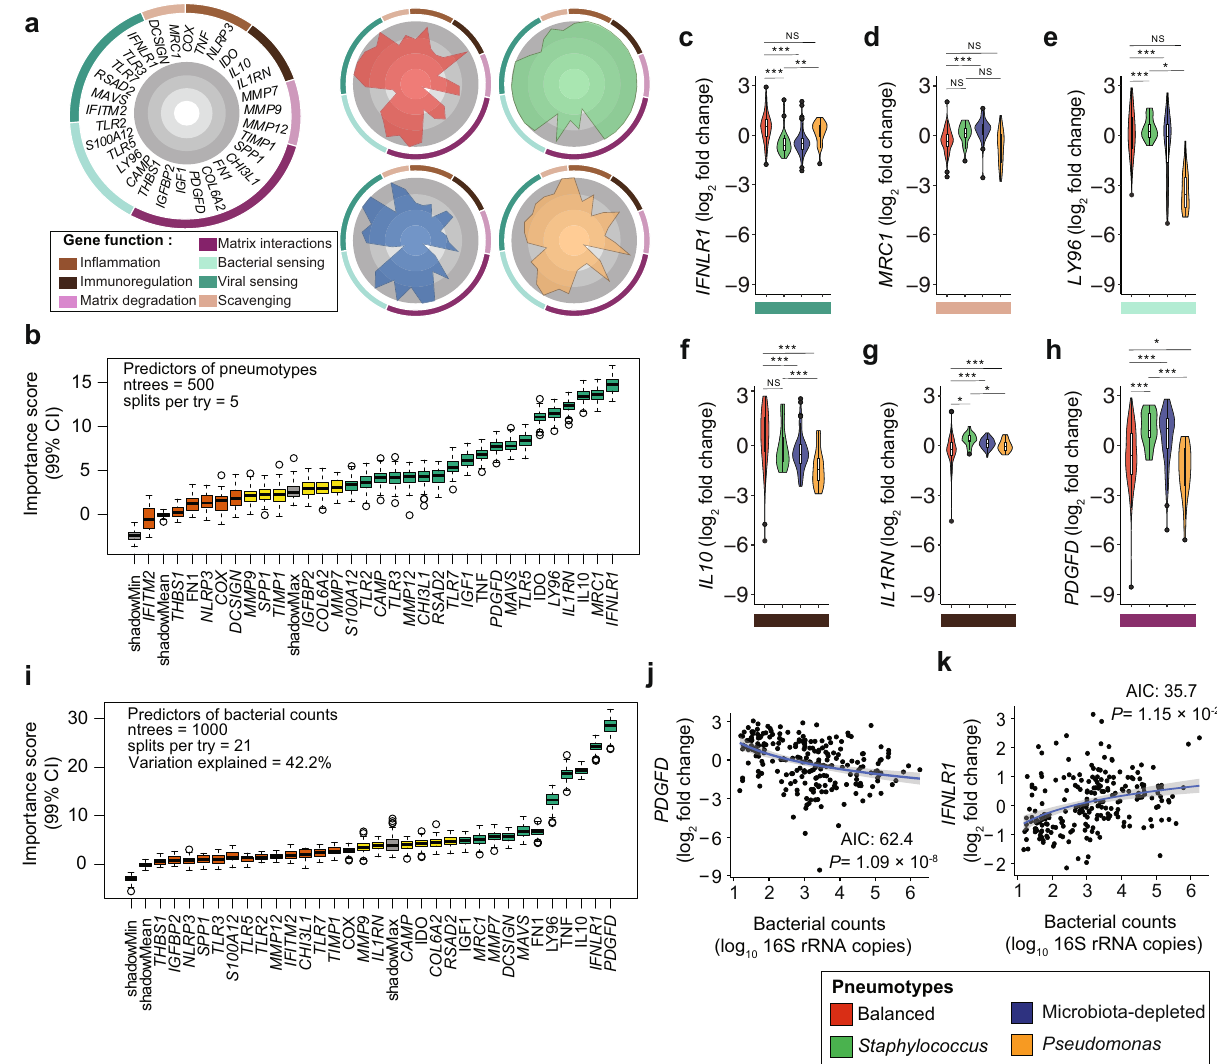
Fig. 4 Host gene expression in the lung differs according to pneumotype and bacterial load. a Radar plots show median-normalized expression of 31 host genes (radial axes) in the cell fraction of all BALF samples split by four pneumotypes. Circular distribution of genes is color-coded by seven functional categories and ticks (gray shading) show increase in expression from the inside to outside of the circle. b Importance scores (99% Con fi dence Interval) of host genes predictors of pneumotypes analyzed by Random Forest classi fi cation model and Boruta feature selection. Predictor genes are categorized into Con fi rmed (Green), Tentative (Yellow) and Rejected (Orange), ntrees = number of decision trees, splits per try = number of random predictors sub- sampled. c – h Violin plots showing distribution of expression (log 2 fold) of host genes with Importance scores >10 for pneumotype prediction ( n = 229): IFNLR1 (Kruskal test, χ 2 = 59.18, df = 3, two-sided, P = 8.8 × 10 − 13 ), MRC1 (ANOVA, F (3, 225) = 17.93, two-sided, P = 1.8 × 10 − 10 ), LY96 (Kruskal test, χ 2 = 33.87, df = 3, two-sided, P = 2.1 × 10 − 7 ), IL10 (Kruskal test, χ 2 = 58.82, df = 3, two-sided, P = 1.0 × 10 − 12 ), IL1RN (Kruskal test, χ 2 = 58.02, df = 3, two- sided, P = 1.5 × 10 − 12 ) and PDGFD (Kruskal test, χ 2 = 58.02, df = 3, two-sided, P = 8.7 × 10 − 10 ) across the pneumotypes. i Importance scores (99% Con fi dence Interval) of host genes in predicting bacterial counts analyzed by Random Forest regression model and Boruta feature selection. In addition to ntrees and splits per try = number of random predictors sub-sampled at each step and percent variance explained. j , k Scatter plots show correlation between expression(log 2 fold) of PDGFD (stepwise regression AIC = 62.4, ANOVA, t = − 5.9, P = 1.09 × 10 − 8 ) and IFNLR1 (stepwise regression AIC:35.7, ANOVA, t = 2.5, P = 1.15 × 10 − 2 ) and bacterial counts (log 10 16 S rRNA copies) across samples ( n = 234). Linear regression is shown by the blue line with gray shaded area showing 95% con fi dence interval. All box plots including insets show median (middle line), 25th, 75th percentile (box) and 5th and 95th percentile (whiskers) as well as outliers (single solid/hollow points). Post hoc analyses (95% Con fi dence Interval) were done by using Tukey ’ s test (ANOVA) or Dunn ’ s test (Kruskal test) with False Discovery Rate (FDR). * P < 0.05, ** P < 0.01, *** P < 0.001, NS = not signi fi cant.